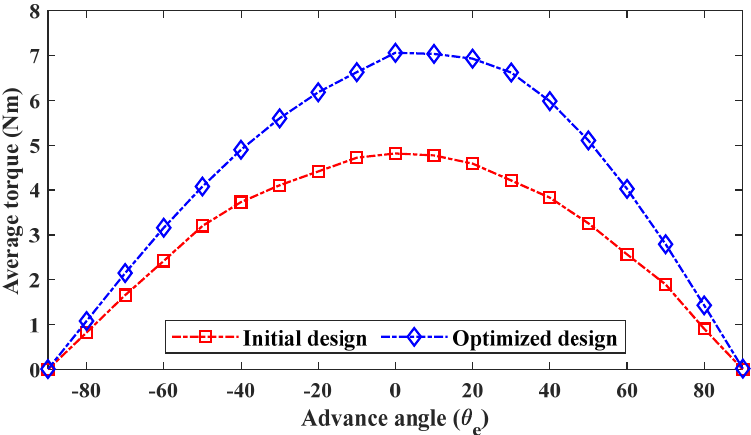
Figure 16. Torque w.r.t different electrical degrees before and after optimization.